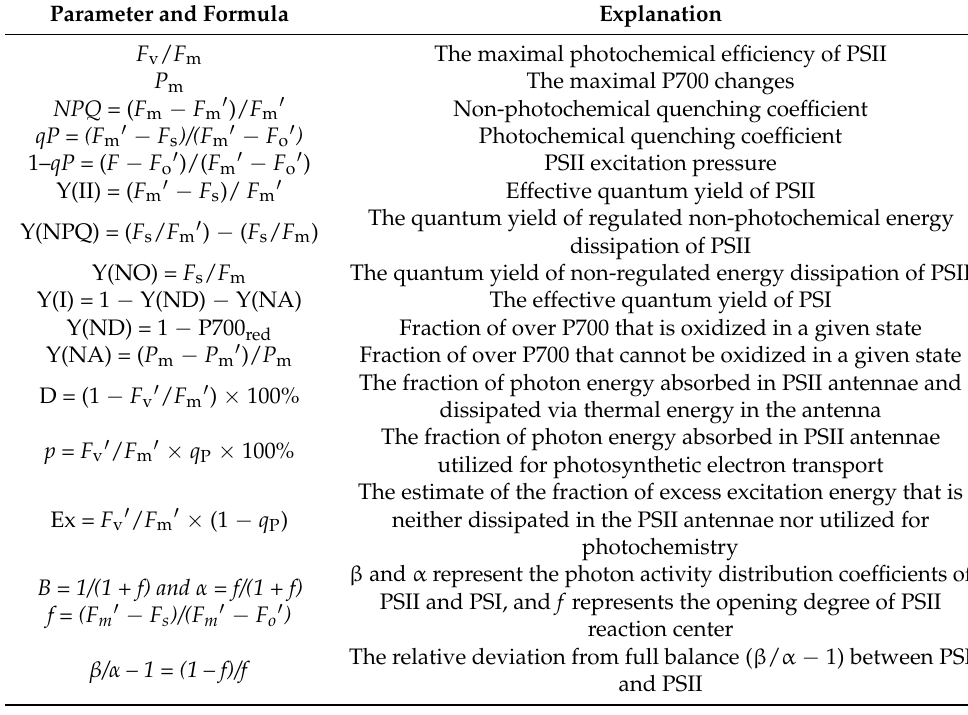
Table 1. Parameters of chlorophyll